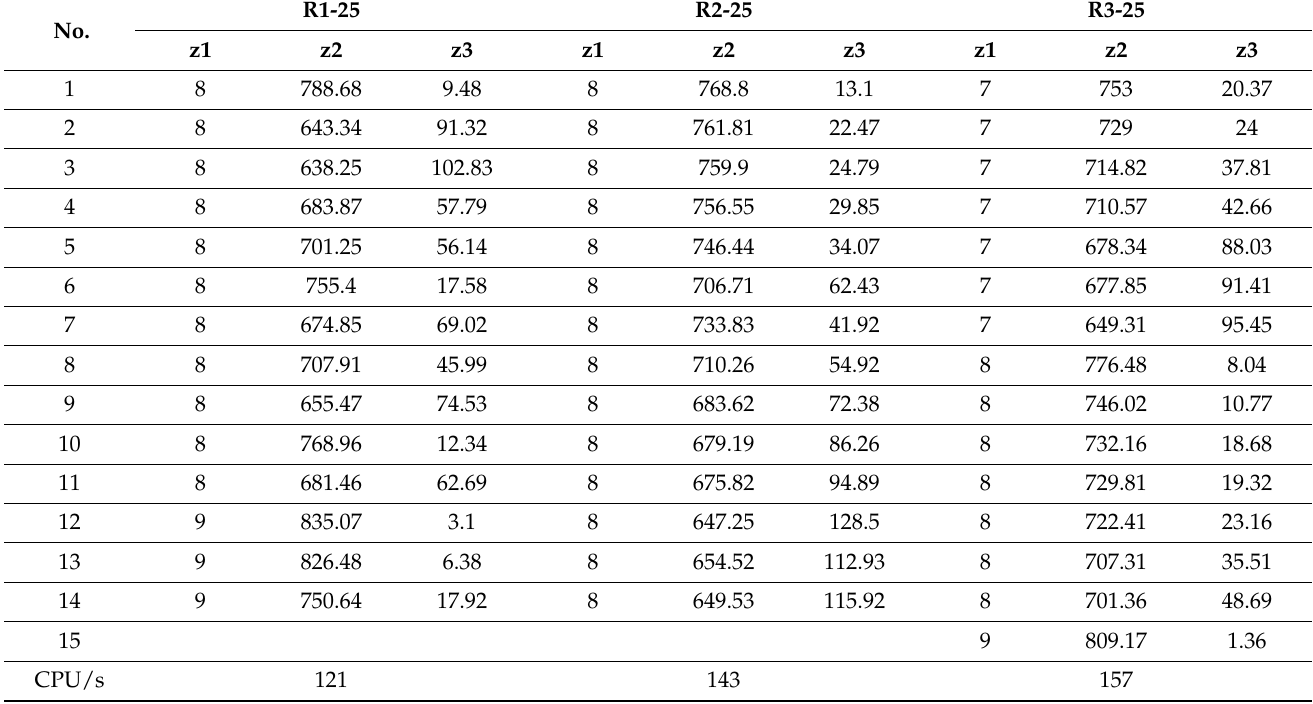
Table 6. Results of the